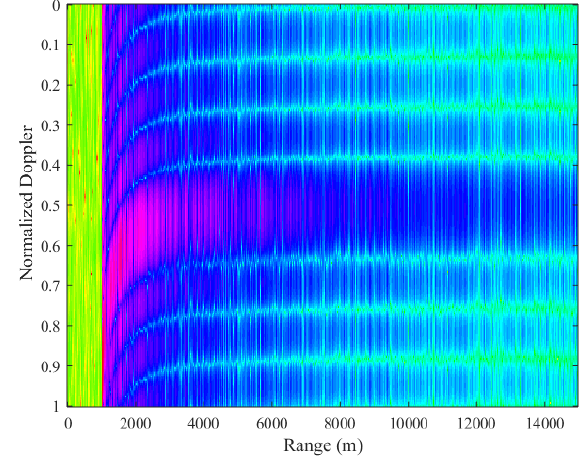
Figure 9. Range–Doppler map of raw data.